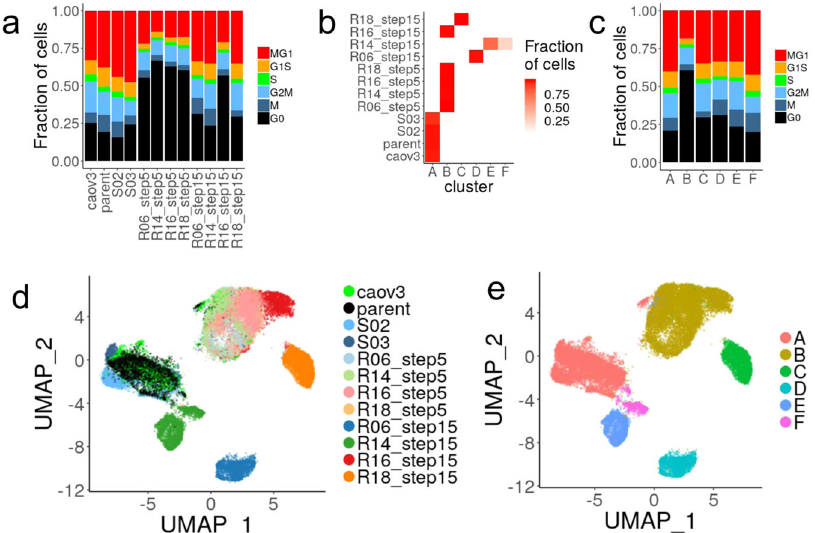
Fig. 3 Evolution of expression states in all clones. a Distribution of cells in three phases of the cell cycles estimated from the expression signatures. b Distribution of the cells from each clone and treatment group across the 6 clusters. c Distribution of cells in three phases of the cell cycles estimated from the expression signatures. ( d , e ) Uniform Manifold Approximation and Projection (UMAP) of cells from the aggregated analysis based on the fi rst 2 principal components. Cells are colored according to their sample of origin ( d ) or Louvain cluster ( e